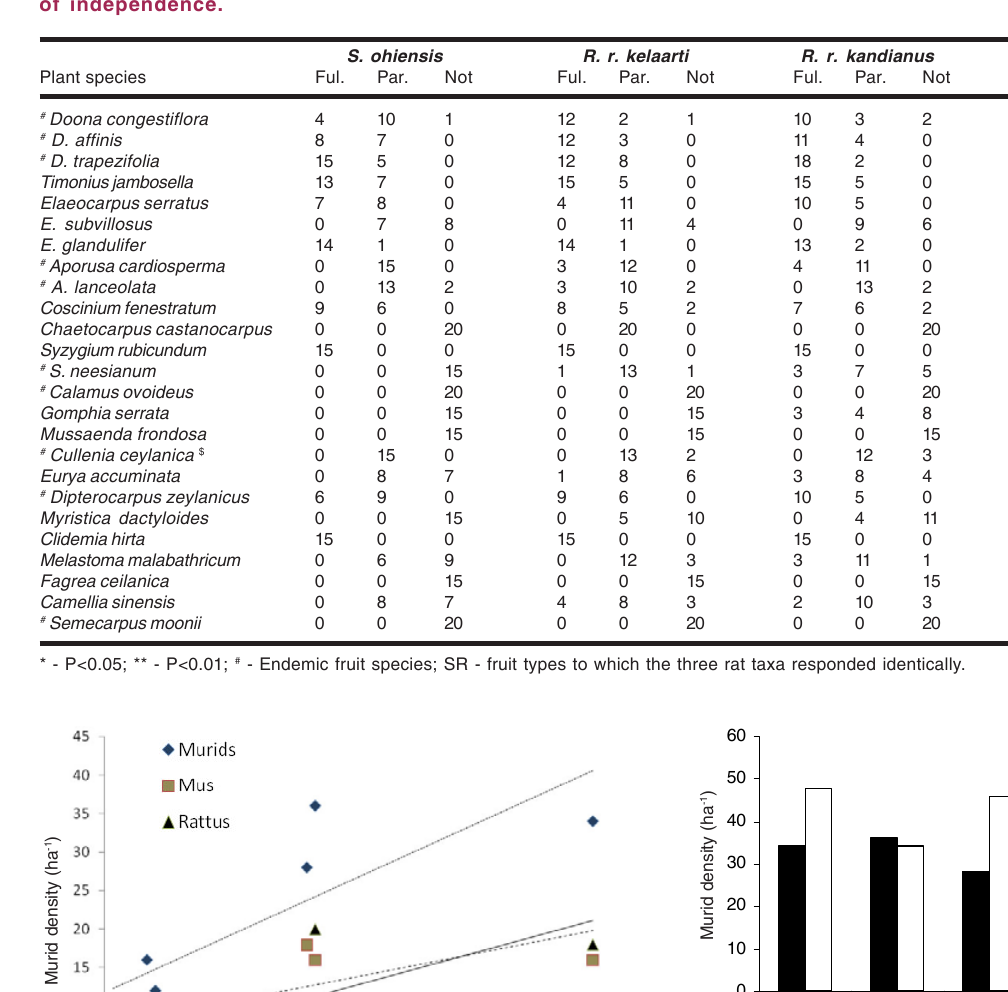
Table 1. Selection of 25 different fruit types by three rodents Srilankamys ohiensis , Rattus rattus kelaarti and R. r. kandianus during cafeteria trials. The responses of the rodents were scored as fully eaten (Ful.), partially eaten (Par.) or not eaten (Not). Probability values are from chi-square tests of independence.